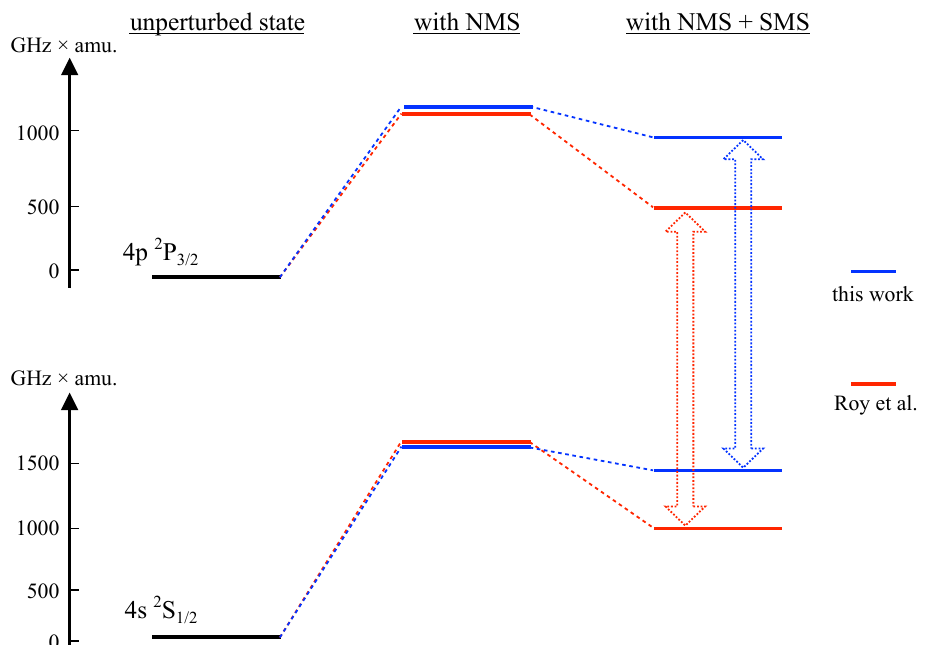
Figure 1. Illustration of calculated mass shifts for the 2 S method, in this work and in [14]. Although the calculated shifts in the two works are distinctly different, the resulting shift of an observed spectral line (which is the experimental observable) is similar for both calculations (498.6 GHz × amu for [14] and 420.69 GHz × amu for the present